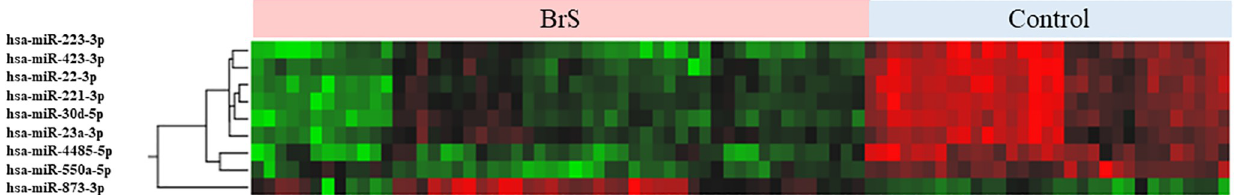
Fig 1. Heat map of hierarchical clustering analysis based on the significantly changed miRNA expression between BrS patients and controls. Some BrS patients showed similar miRNA expression to those of the controls, but there were some notable differences between the BrS patients and the controls. hsa-miR-873–3p and the other miRNAs formed different clusters.